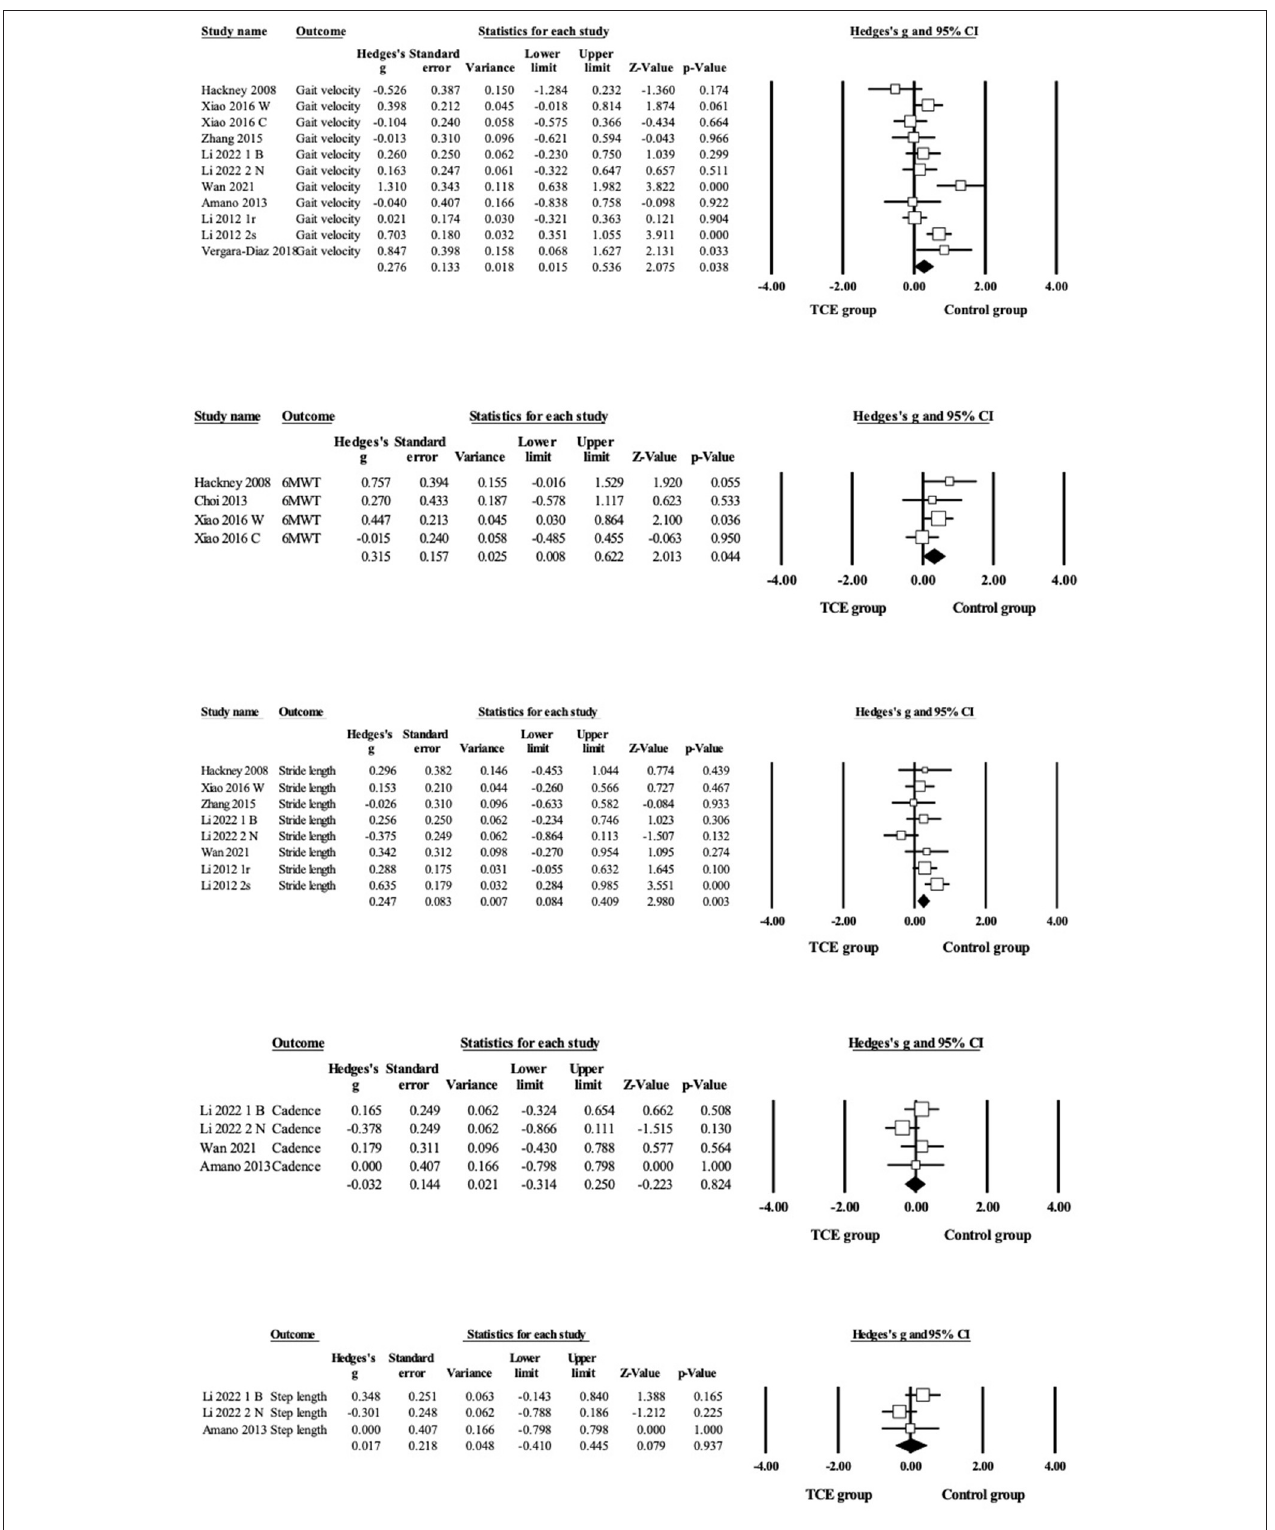
FIGURE 4 | Forest plot showing the effects of TCE vs. control group on gait outcomes: gait velocity, 6 MWT, stride length, cadence, step length.